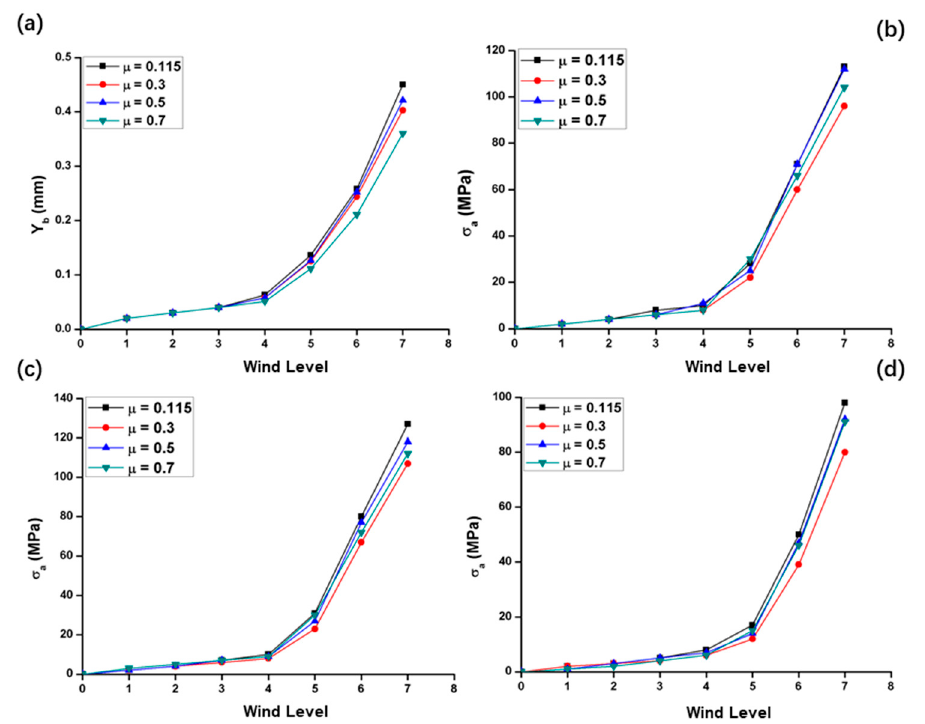
Figure 14. ( a ) E ff ect of the friction coe ffi cient on Y b , ( b ) σ a of the outermost layer, ( c ) σ a of the third Figure 14. ( a ) Effect of the friction coefficient on Y b , ( b ) σ a of the outermost layer, ( c ) σ a of the third layer, and ( d ) σ a of the second layer, and ( d ) σ a of the second layer.